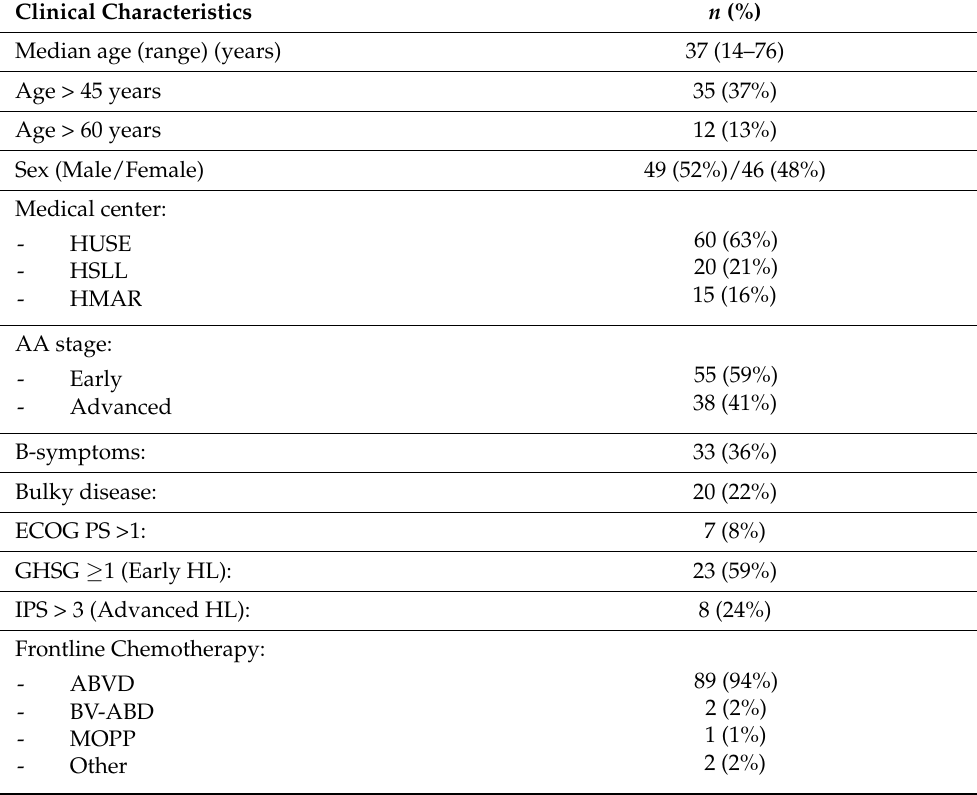
Table 1. Patient characteristics. Clinical